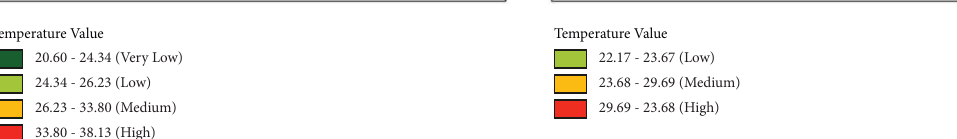
Figure 7: Surface temperature classifcation results in 2015 and 2019 in Banjarmasin